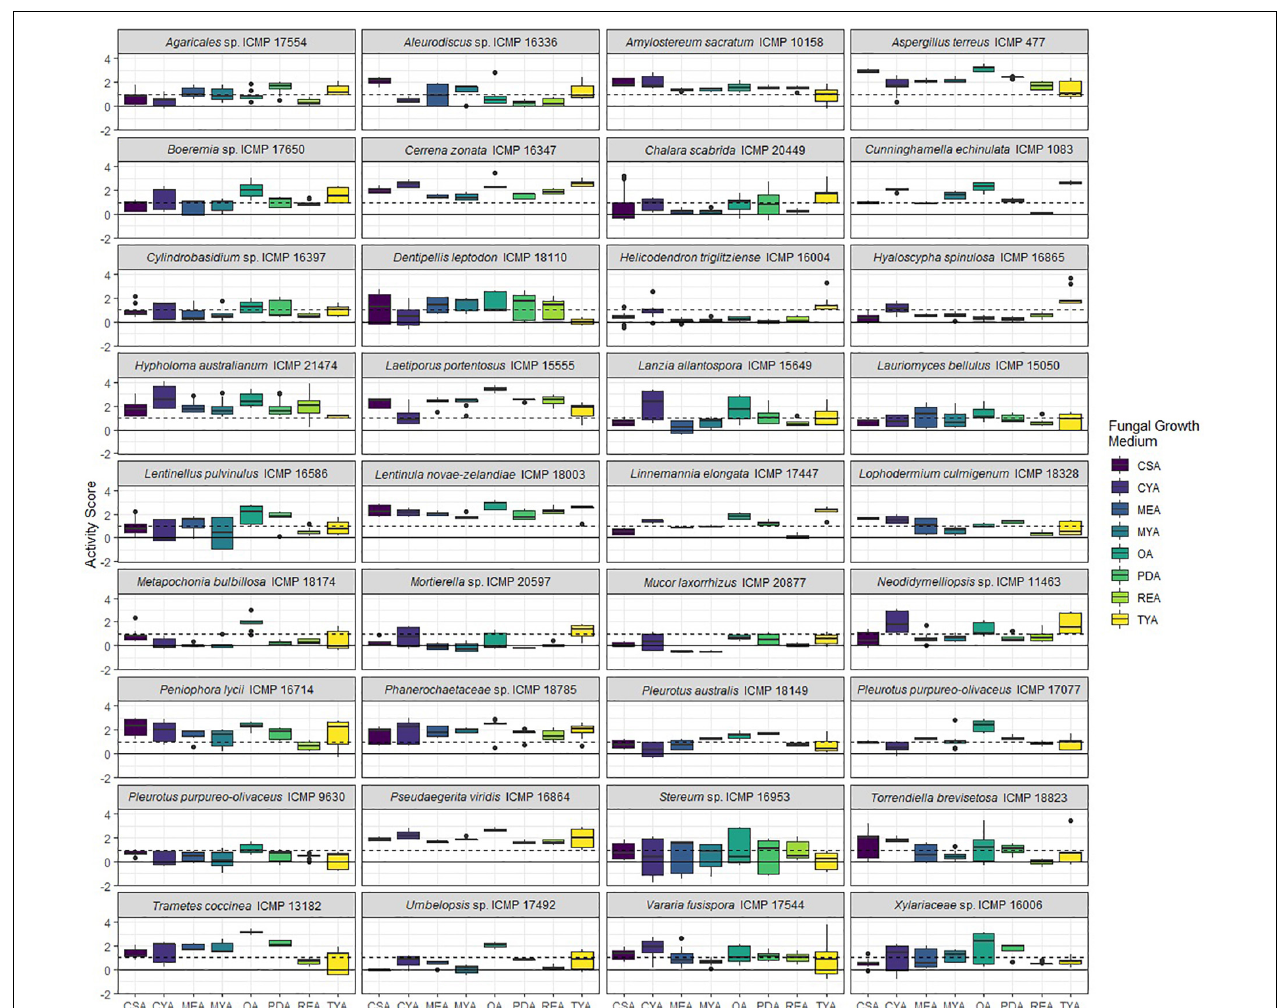
FIGURE 4 | Antibacterial activity of ICMP fungal isolates against Mycobacterium marinum BSG101 when grown on different media. Data is presented as box and whisker plots of activity scores. The solid line shown at 0 is the median control value while the dotted line at 1 is the activity threshold. Scores above 1 correspond to a > 90% reduction in bacterial bioluminescence compared to the corresponding no-fungi control. Similarly, an activity score above 2 means corresponds to a > 99% reduction. CSA, Czapek Solution Agar; CYA, Czapek Yeast Extract Agar; MEA, Malt Extract Agar; MYA, Malt Yeast Extract Agar; OA, Oatmeal Agar; PDA, Potato Dextrose Agar; REA, Rice Extract Agar; TYA, Tryptone Yeast Extract Agar. Boxes are upper and lower quartiles with median shown. The whiskers extend up to 1.5 × the inter-quartile range and any dots beyond those bounds are